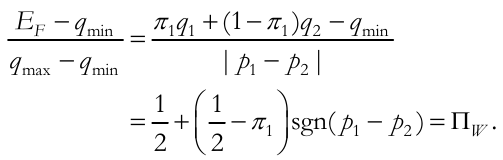
1 , p 2 and ω /(1- ω ) when Ψ I is the trace, compared with Neyman’s N  and the Play-the-Winner target   pW ω /(1- ω